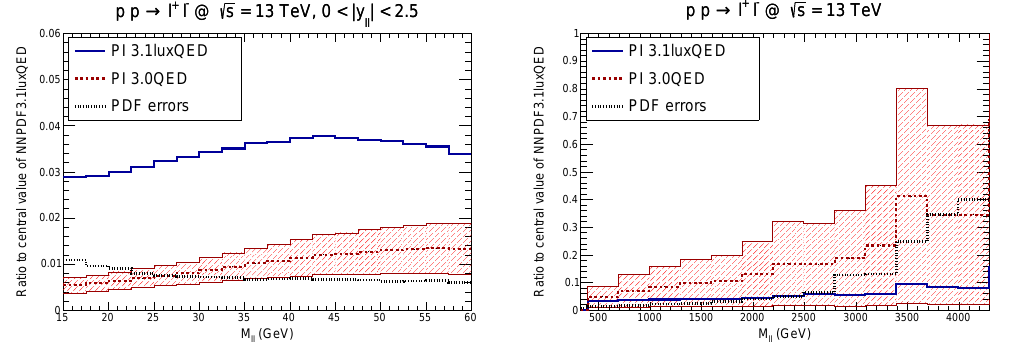
Figure 4.3: Similar representation as the right panel of Fig. 4.2 for the low (left) and high (right plot) invariant mass regions, defined as 15 GeV ≤ M respectively. Please note that the right figure is plotted in a larger y -axis range in comparison to previous plots.